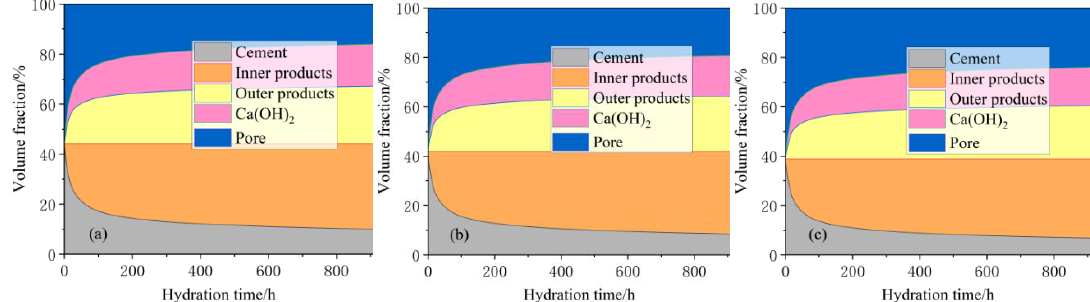
Figure 8. Time-varying curves of volume fraction of mineral components and hydration products under different w/c ratios using HYMOSTRUC3D. ( a ) 0.40; ( b ) 0.44; ( c ) 0.50.